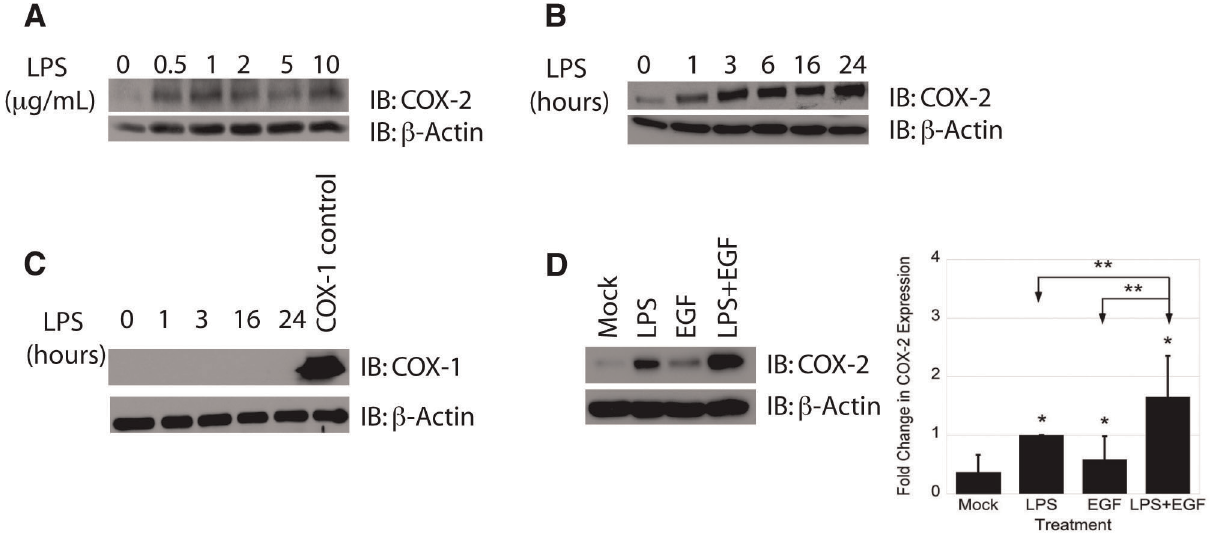
Figure 1. LPS induces COX-2 in IEC-6 cells. A) IEC-6 cells were treated with the indicated concentrations of LPS for 24 hours. B) IEC-6 cells were treated with 2 m g/mL LPS for the indicated time. C) IEC-6 cells were treated with LPS (2 m g/mL) for the indicated times. D) Cells were treated with LPS (2 m g/mL), EGF (10 ng/mL), or co-treated with LPS and EGF for 24 hours. Protein expression was determined by Western blot analysis and densitometry. Treatment with LPS did not induce COX-1 expression in IEC-6 cells. In contrast, treatments with LPS, EGF, or both significantly increased COX-2 expression compared to control (p , 0.001, =0.05, and , 0.001 respectively). Cells treated with LPS and EGF had significantly greater COX-2 expression than by either EGF (p=0.002) or LPS (p=0.006) alone. Single asterisks indicate significant differences from control. Double asterisks indicate significant differences between two bracketed conditions.